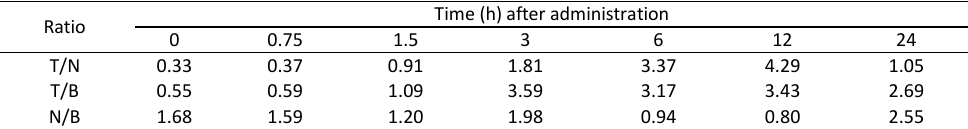
Table 1. T/N, T/B, and N/B boron concentration ratios in mice administration